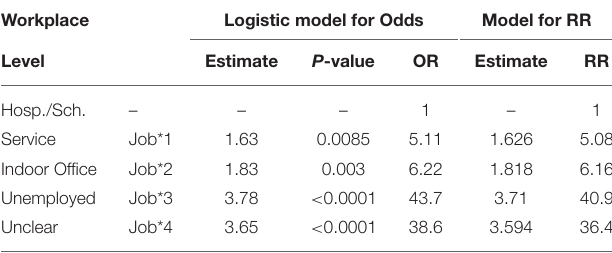
TABLE 7 | OR and RR estimated by using logistic models. Workplace Logistic model for Odds Model for RR Level Estimate P -value OR Estimate RR